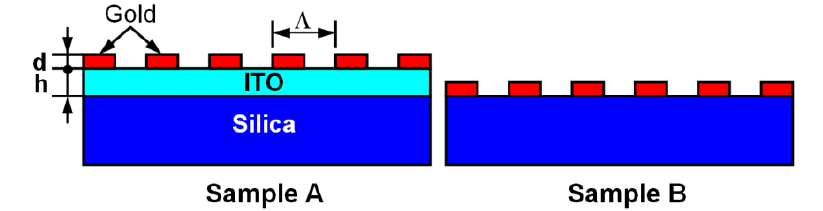
Figure 5. Schematic illustration of waveguide gold nano-line grating ( sample A ) and gold nano-line grating sitting on the substrate ( sample B